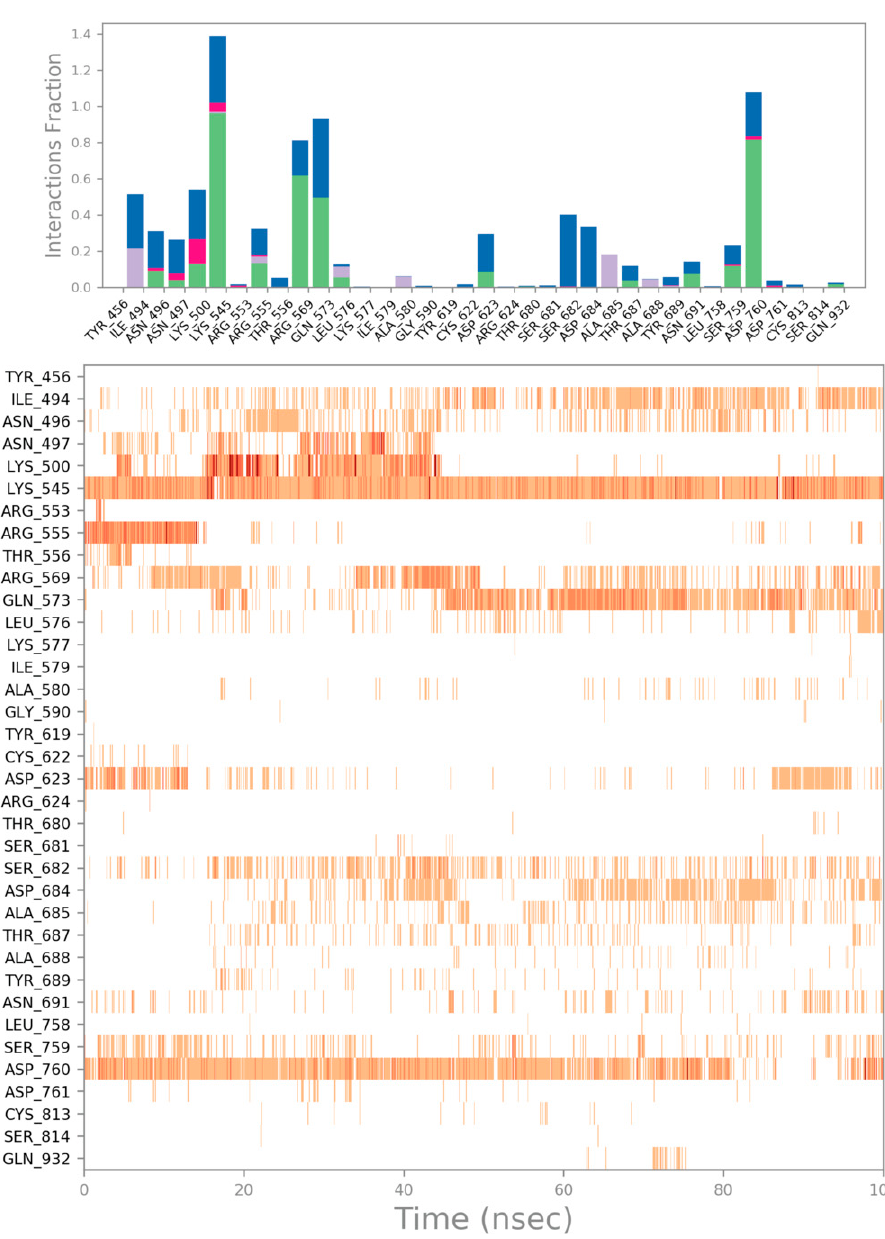
Figure 5. Compound 2 monitored during the simulation. The contacts can be grouped by type and summarized, as shown in the plots. Grouping protein–ligand interactions into four types: H-bonds (green), hydrophobic (grey), ionic (magenta), and water bridges (blue). The second graph of the picture displays a timeline representation of the contacts. Some residues make more than one specific contact with the ligand, which is represented by a darker shade of orange.